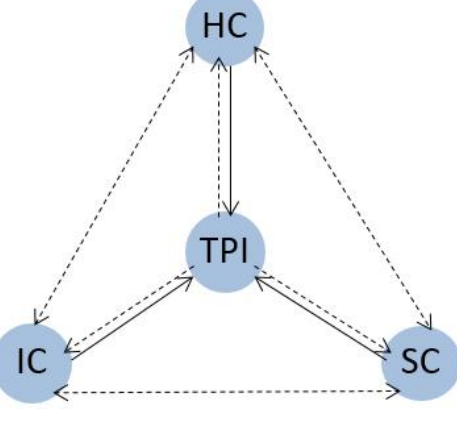
Figure 3: Scheme of the TPI production function (positive externalities for effective cluster